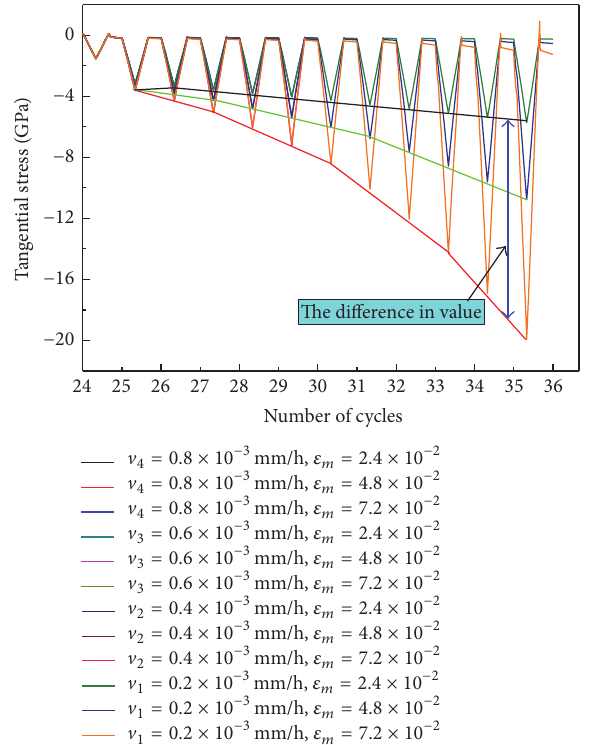
Figure 11: The variation of the tangential stress at element number 20857atthebaseofthesurfacegrooveagainstthenumberofthermal cycles for all conditions of MZ growth rate.